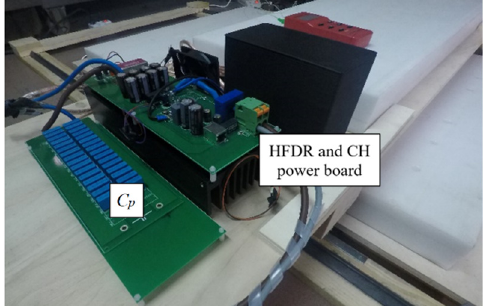
Figure 14. High frequency diode rectifier (HFDR), chopper (CH), and compensation network of the pickup coil.